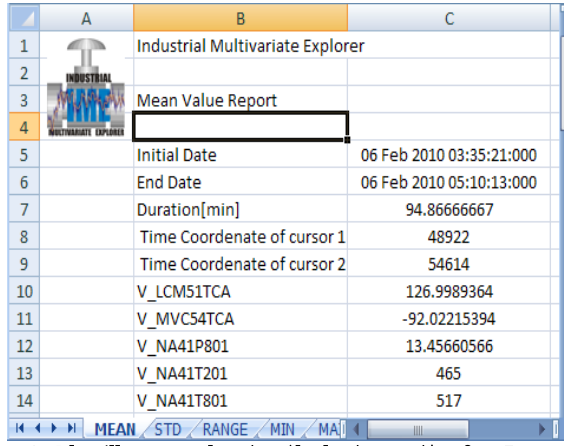
Figura 9. Plantilla para salva de cálculo de estadígrafos. Formato de fecha y tiempo.